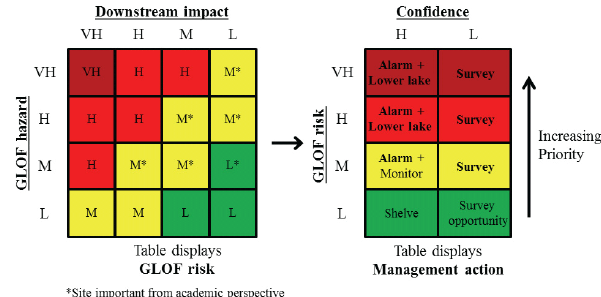
Figure 5. Risk management and action framework. Left table: GLOF risk is a function of the hazard and downstream impact. Right table: the recommended course of action for a given glacial lake based on the type of